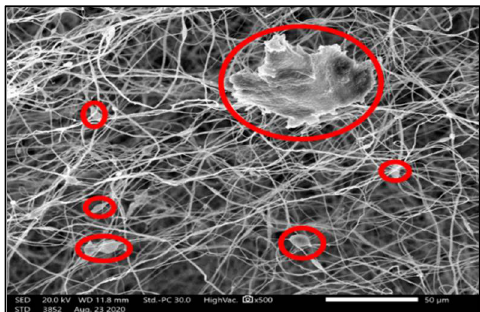
Figure 12. SEM for PVDF membrane after dye treatment.